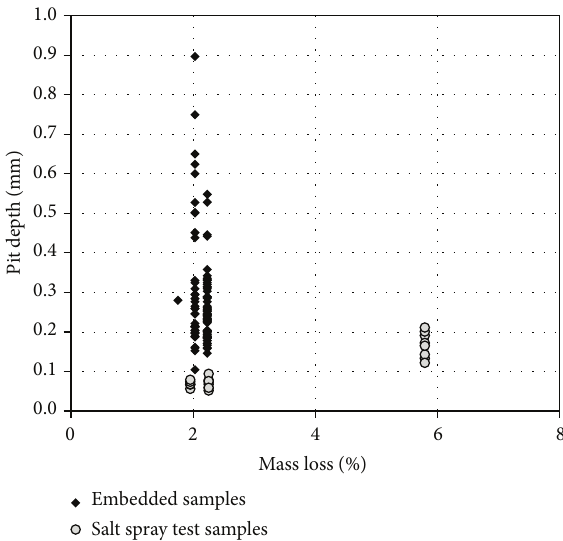
Figure 10: Pit depth depending on mass loss for embedded samples and salt spray